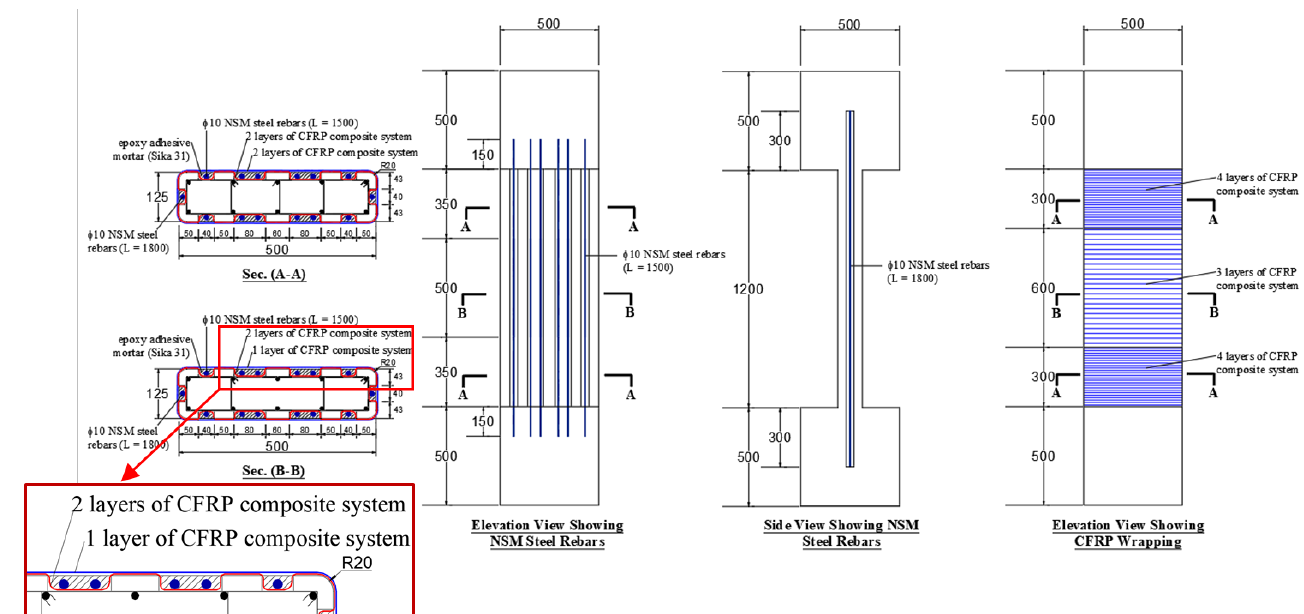
Figure 4. Dimensions and reinforcement detailing of strengthened specimen SW3 (note: all dimen- sions are in mm).